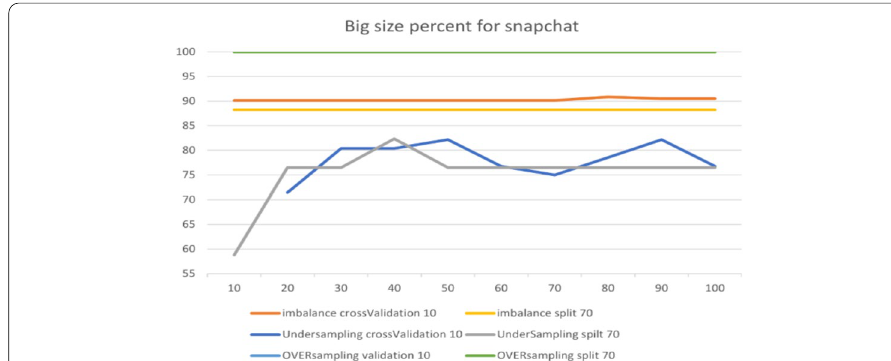
Fig. 17 The accuracy of BigSizePercent for RF in Snapchat